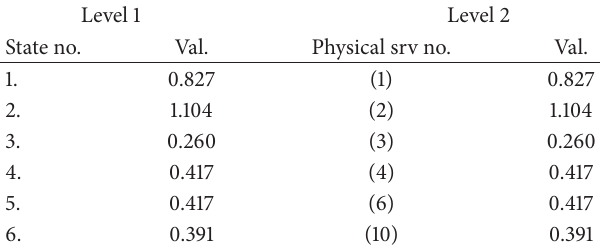
Table 5: Sensitivity analysis for scn. no. 1.